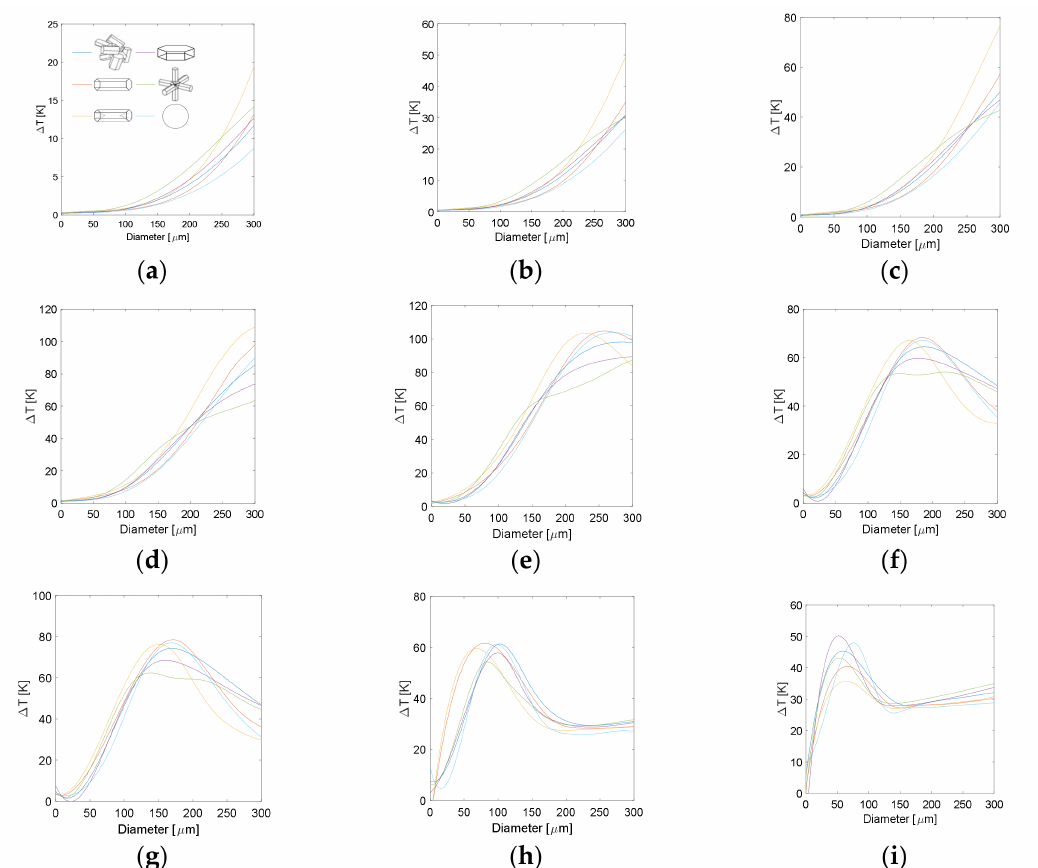
Figure 2. Brightness temperature di ff erence caused by di ff erent particle shapes. ( a ) 118.75 ± 5.0 GHz (O2). ( b ) 157.05 ± 2.6 GHz (Window). ( c ) 183.31 ± 7.0 GHz (H2O). ( d ) 243.20 ± 2.5 GHz (Window). ( e ) 325.15 ± 9.5 GHz (H2O). ( f ) 424.70 ± 4.0 GHz (O2). ( g ) 448.0 ± 7.2 GHz (H2O). ( h ) 664.0 ± 4.2 GHz (Window). ( i ) 874.4 ± 6.0 GHz